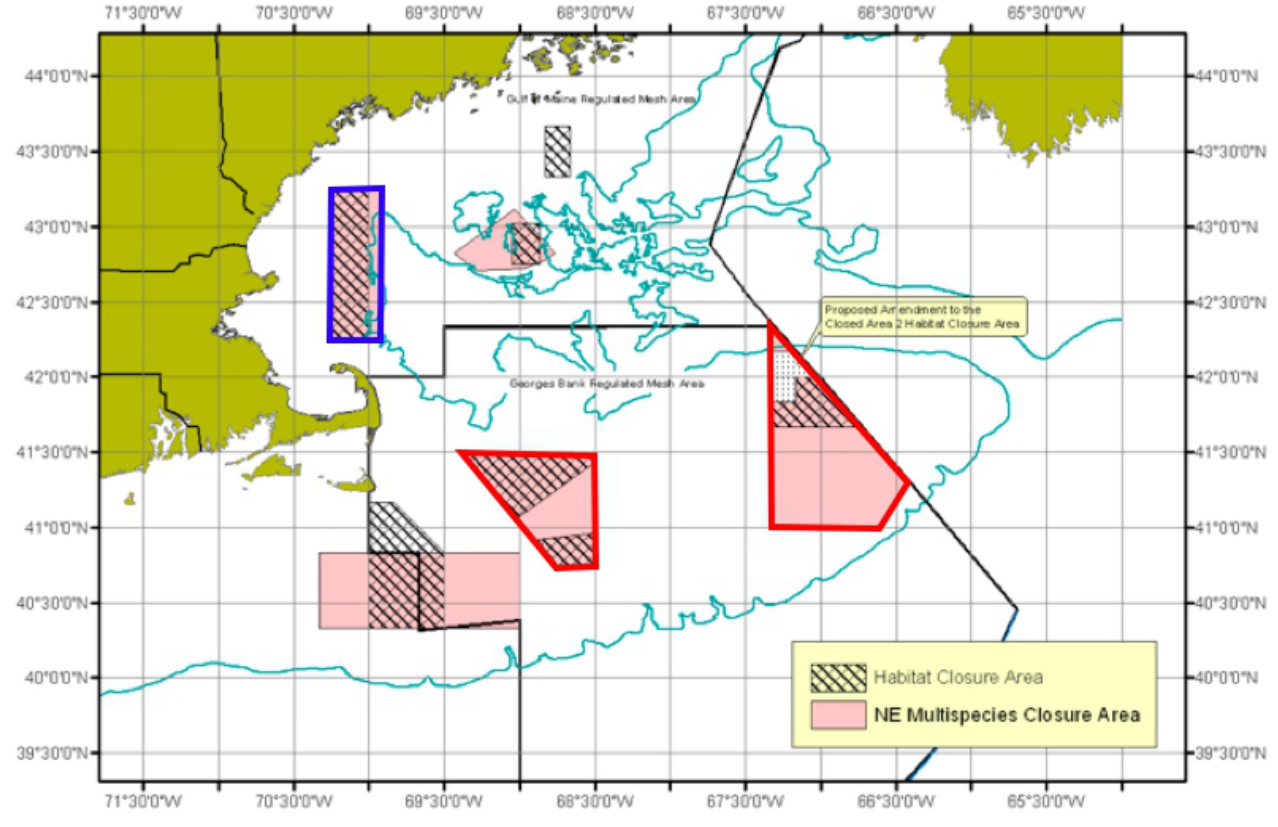
Fig. 2 . Area and habitat closures designated by the New England Fishery Management Council (NEFMC) as of 2007. The first two area closures (marked in red) were created on Georges Bank in 1994. Western Gulf of Maine Area Closure (WGoMAC; marked in blue) was created in 1998 (Framework Adjustment 25 to the Northeast Multispecies Fishery Management Plan). 2004 amendments (Amendment 13 to the to the Northeast Multispecies Fishery Management Plan) created habitat closures (marked with diamond pattern). In the case of WGoMAC, new regulations divided original area closure into habitat closure and rebuilding closure. (Map source: National Oceanic and Atmospheric Administration [NOAA] - National Marine Fisheries Service [NMFS], Northeast Regional Office